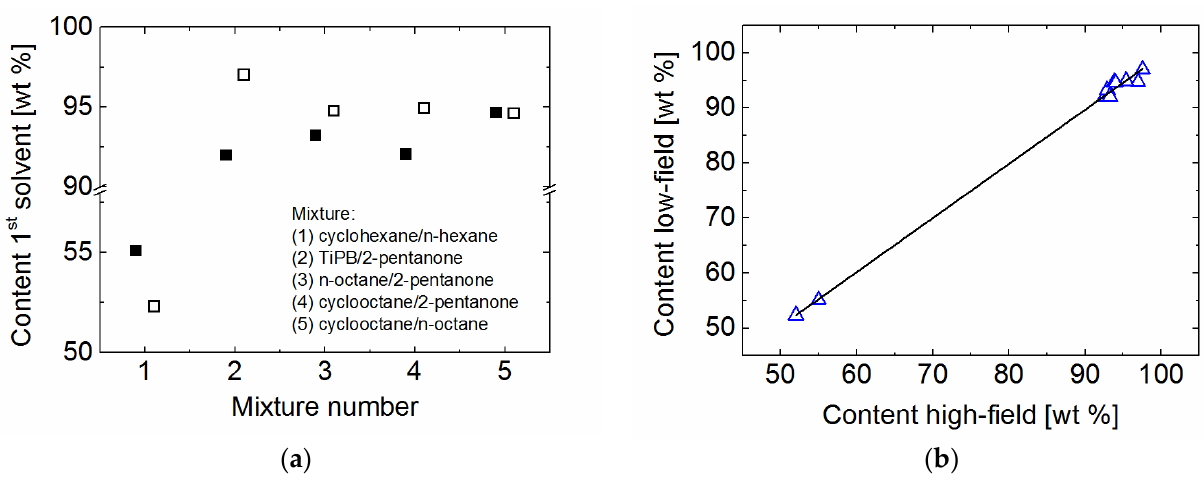
Figure 4. ( a ) Content of the first solvent before (filled symbols) and after (empty symbols) extraction by MOF as calculated based on the T 2eff values given in Figure S3. For the n-hexane/cyclohexane a mixture with around 55 wt % cyclohexane was tested. The errors of the obtained values are lower than 0.5%. ( b ) Correlation of the solvent content in the mixture before and after separation as determined by low-field relaxometry and high-field liquid-state spectroscopy. For the sake of comparison, the results of all mixtures presented in Figure 4a are included. The continuous line is the linear fit result with a correlation factor of